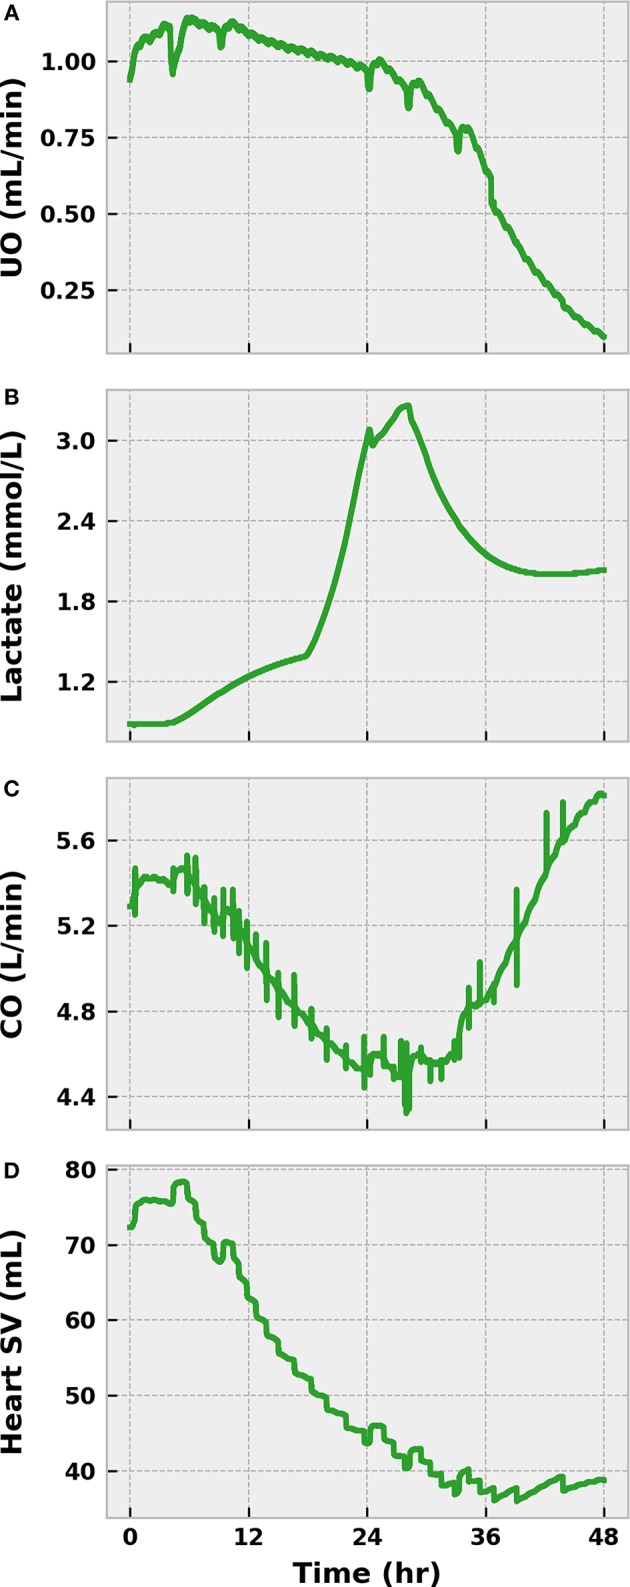
The progression of severe infection to sepsis and septic shock in the BioGears Engine (Part 2). Tubulerglomerular feedback from the renal system responds to low circulating volume by decreasing UO (A). The effect of tissue damage on cellular respiration becomes apparent as lactate accumulates in the blood (B). The sharp changes in concentration likely occur as the BioGears renal model attempts to consolidate substance clearance with low glomerular filtration rates. Symptoms of cardiac distress arise as (C) CO and stroke volume (SV) fall (D). Though CO increases in the latter stages due to enhanced tachycardia, the underlying SV dysfunction remains. The virtual patient can be diagnosed with septic shock at ~45 h due to the severe hypotension (Figure 6) and the hyperlaktemia.